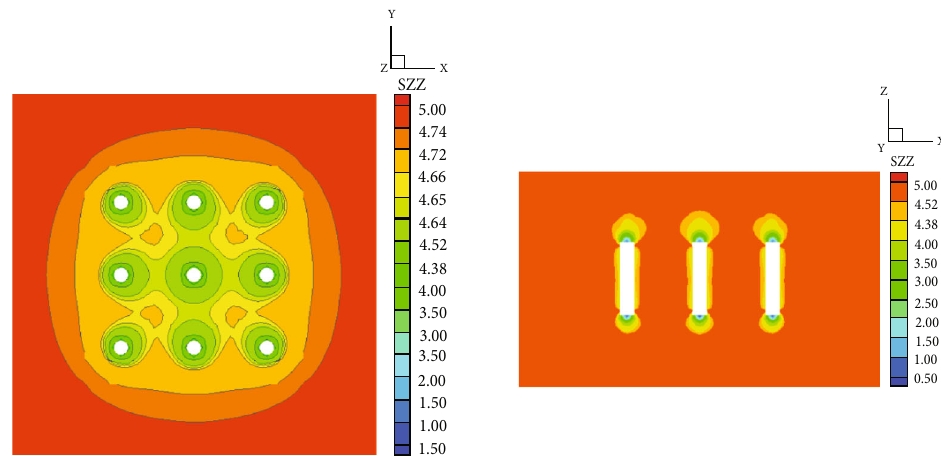
Figure 6: Stress fi eld distribution diagram of horizontal and vertical pro fi les after hydraulic perforation.